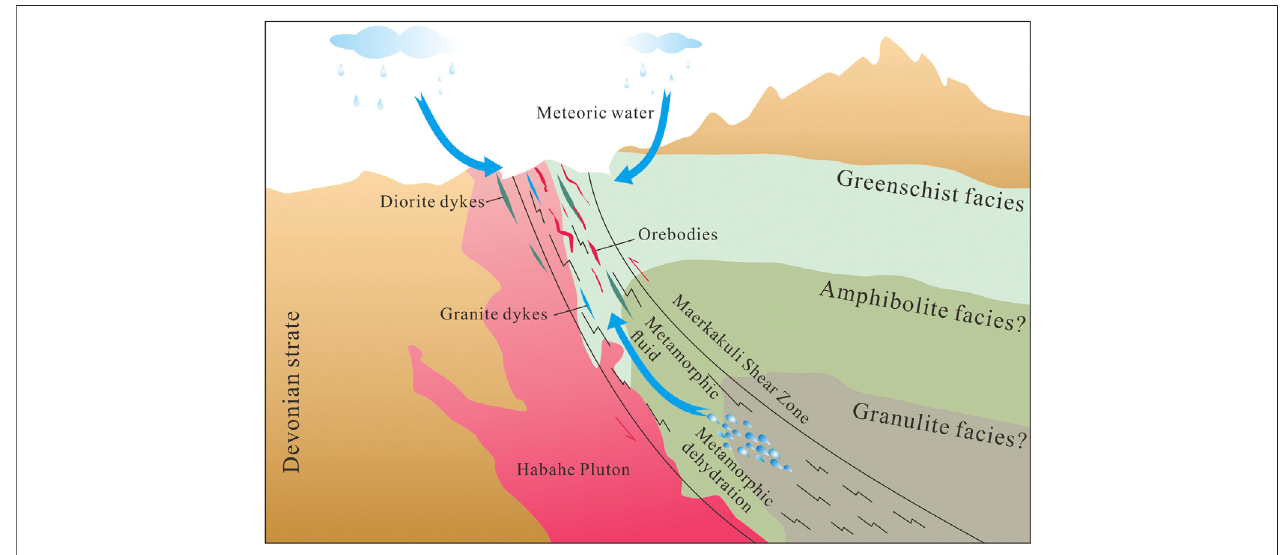
FIGURE 10 | Metallogenic model of the Jinba gold